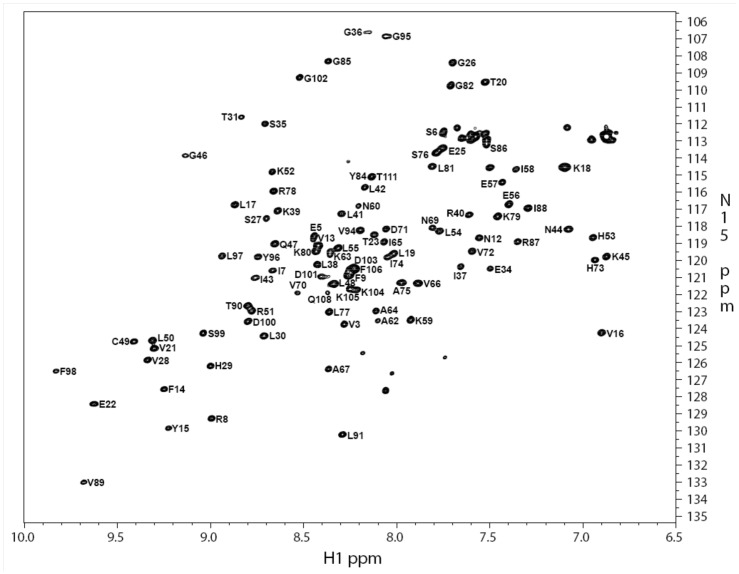

1H-15N HSQC spectrum of ChxREff.2D 1H-15N HSQC spectrum of 1.5 mM 15N, 13C labeled ChxREff acquired on a BRUKER AVANCE 800 NMR spectrometer at 25°C. Cross peaks are labeled with their corresponding backbone assignments.